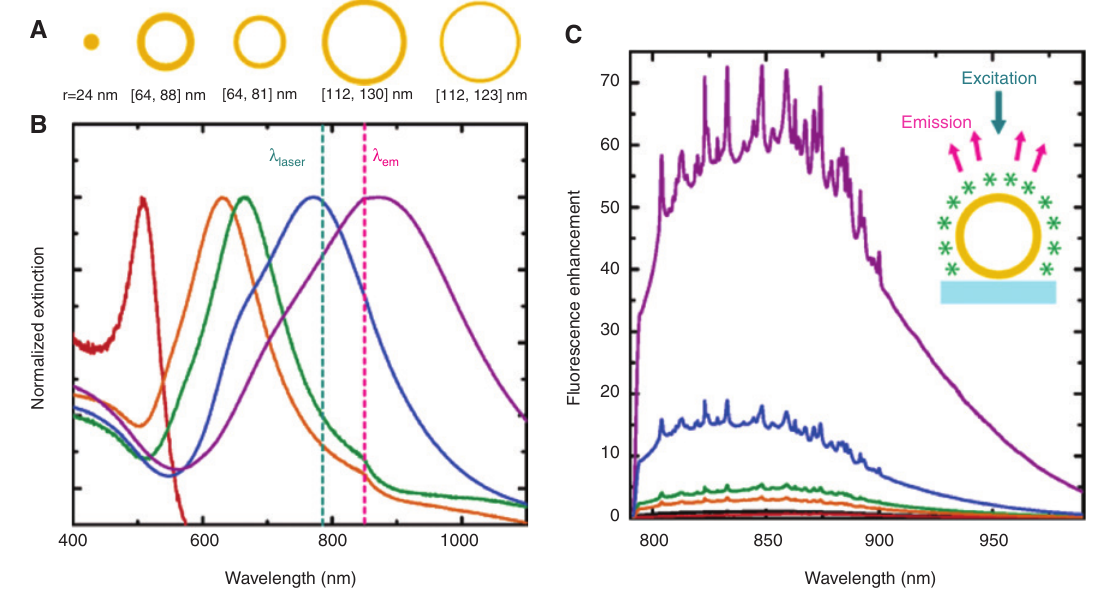
Figure 21: (A) Schematic of gold nanoparticles used as fluorescence enhancement substrates, arranged from short to long plasmon reso- nance wavelength. One Au colloid and four nanoshells of various [r1, r2] were used. (B) Normalized extinction measurements from nanopar- ticle substrates corresponding to (A) in air prior to HSA and ICG deposition. The laser excitation is at 785 nm, and the emission wavelength of ICG attached to HSA is 850 nm. (C) Corresponding fluorescence emission from ICG conjugated to the nanoshell substrates adjusted for surface area available for fluorophore conjugation and normalized to the fluorescence from a control sample with no nanoparticles (black). Inset schematic illustrates experimental geometry. Adapted with permission from Ref. [145]. Copyright (2015) American Chemical Society.